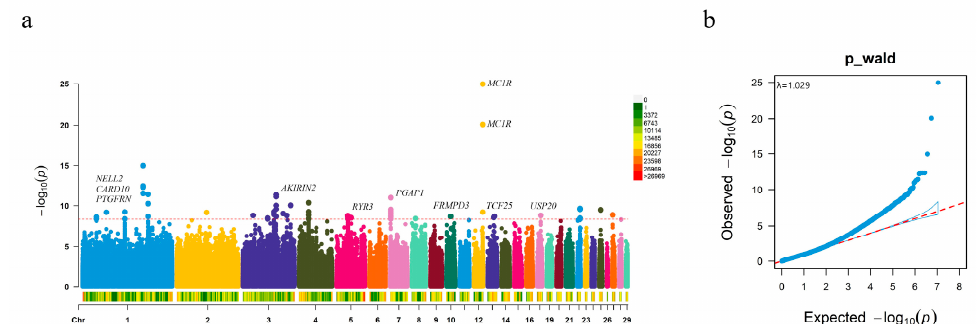
Figure 2. Genome-wide association study results for black plumage. ( a ) Manhattan plot of GWAS results. The Y -axis shows -log10( p -values). The red dashed horizontal line indicates the genome- wide significance threshold (4.583099 × 10 − 9 ). ( b ) Q-Q plot. Lambda ( λ ) is the genomic expansion factor. A total of 16 ducks showed black plumage, and 56 controls were spotty.